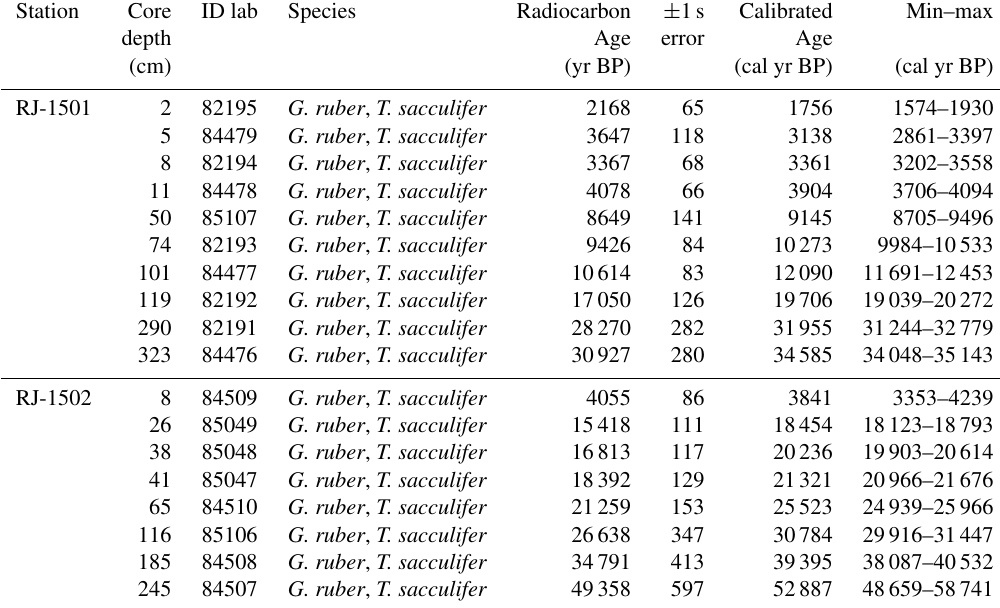
Table 1. Accelerator mass spectrometer radiocarbon (MICADAS) dates and calibrated ages used for age–depth models of cores RJ-1501 and